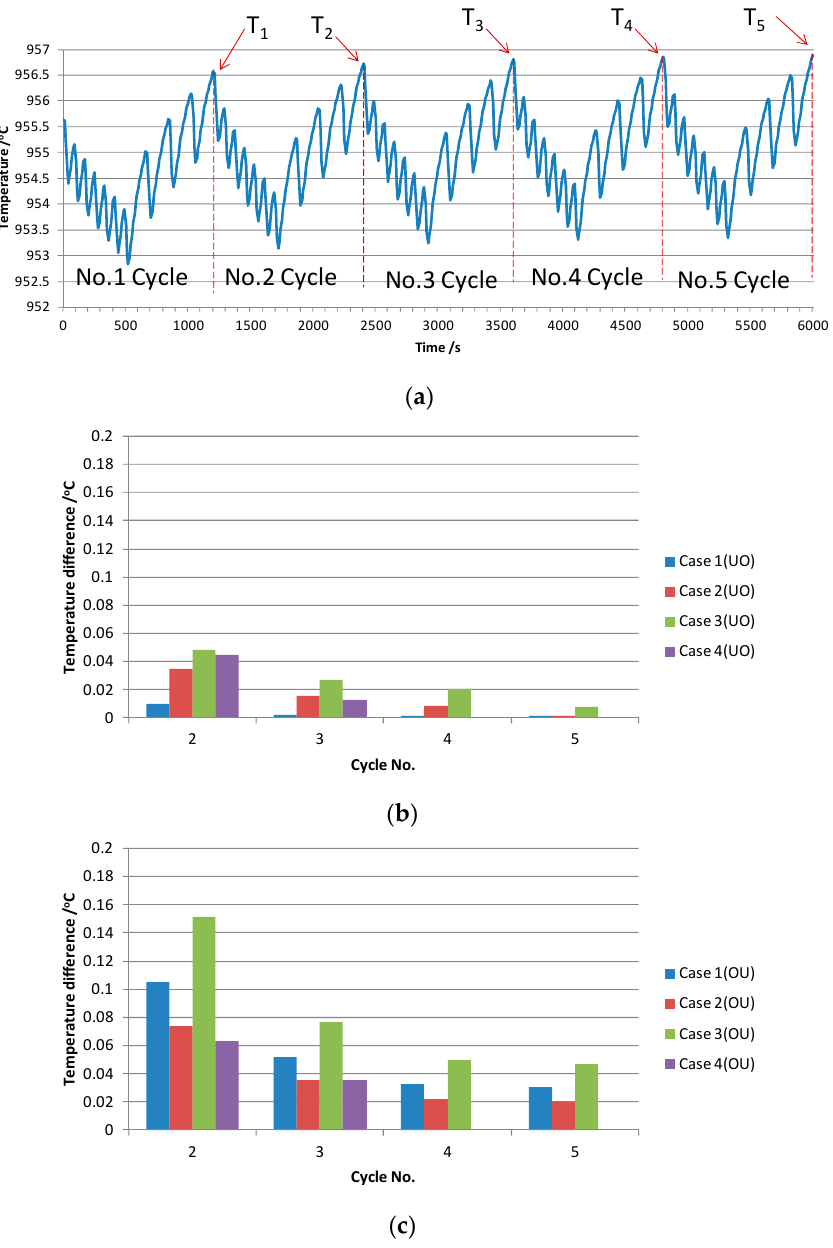
Figure 8. ∆ T of each cycle. ( a ) Illustration of ∆ T; ( b ) underfeeding followed by overfeeding; Figure 8. Δ T of each cycle. ( a ) Illustration of Δ T ; ( b ) underfeeding followed by overfeeding; ( c ) ( c ) overfeeding followed by overfeeding followed by underfeeding.